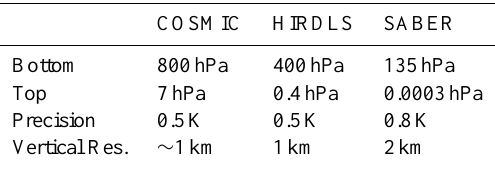
Table 1. Data specifications for each